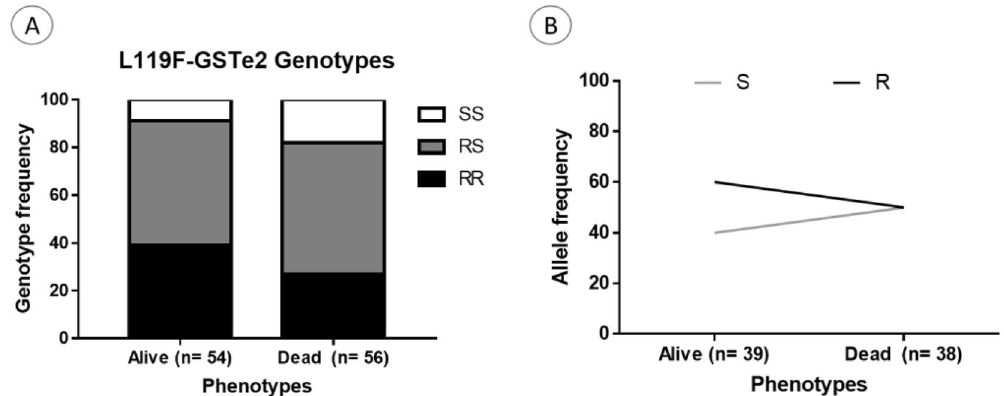
Figure 7. Association between the L119F-GSTe2 mutation and resistance to chlorfenapyr in An funestus. Distribution of genotypes and alleles among the dead and alive mosquitoes after exposure to chlorfenapyr. R represents the resistant allele while S represents the susceptible